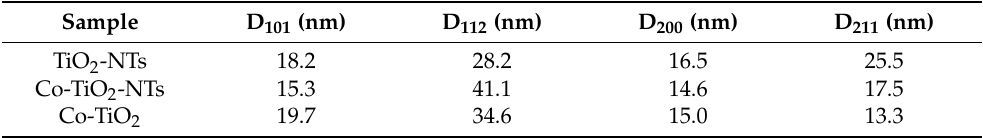
Table 1. Mean crystallite sizes calculated from the Scherrer’s equation based on achieved XRD patterns for TiO 2 -NTs, Co-TiO 2 -NTs and Co-TiO 2 .